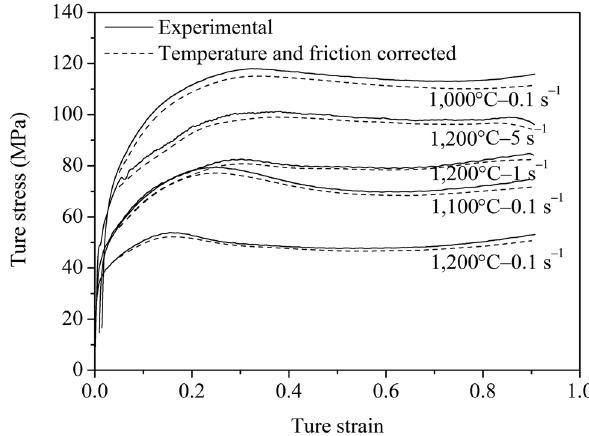
Figure 6: Comparison between the double-corrected and measured flow